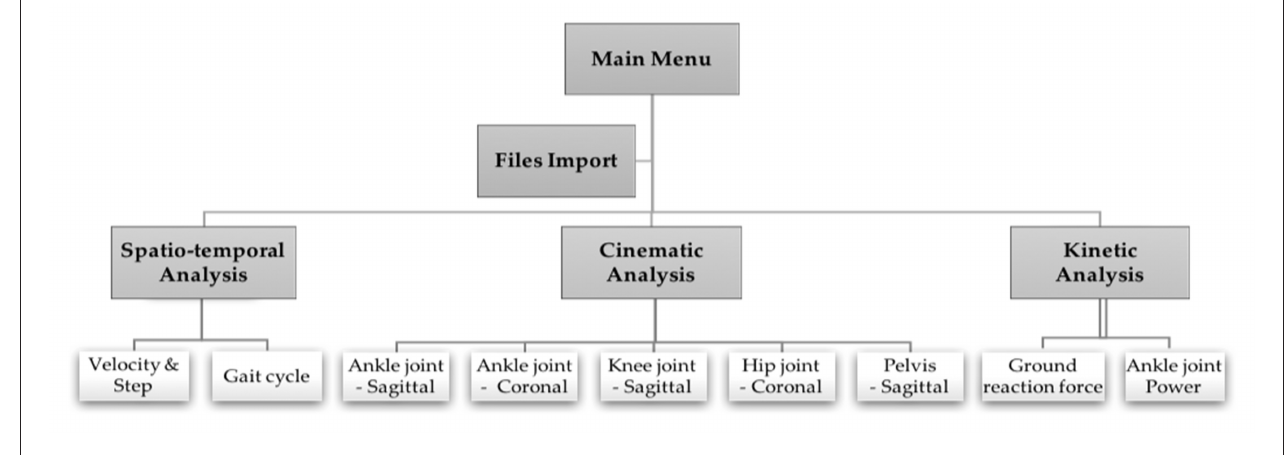
FIGURE 1 | Program structure.